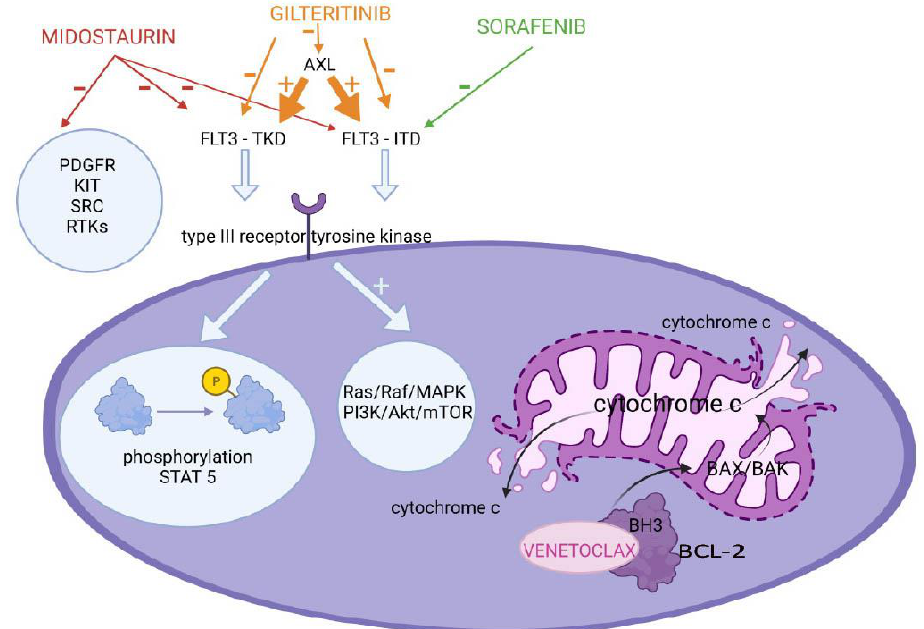
Figure 1. Mechanism of action of the FLT3 and BCL − 2 inhibitors. Midostaurin, gilteritinib and sorafenib by inhibiting the mutated type III receptor kinase cause the inhibition of STAT5 phosphorylation and deactivation of the Ras/Raf/MAPK and PI3K/Akt/mTOR pathways, suppressing tumor cell growth. Venetoclax binds to the BH3 − binding groove of the BCL − 2 protein. This causes the oligomerization and conformational change of BAX and BAK, leading to the formation of pores and mitochondrial outer membrane permeabilization, resulting in tumor cell death. FLT3 mutations cause constitutive activation of the tyrosine kinase, causing uninhib- ited cellular growth.The two major types of FLT3 mutations are: internal tandem duplica- tion mutations in the juxtamembrane domain (FLT3-ITD) and point mutations (the most common is a missense point mutation at the D835) or deletion in the tyrosine kinase do- main (FLT3-TKD) [24].